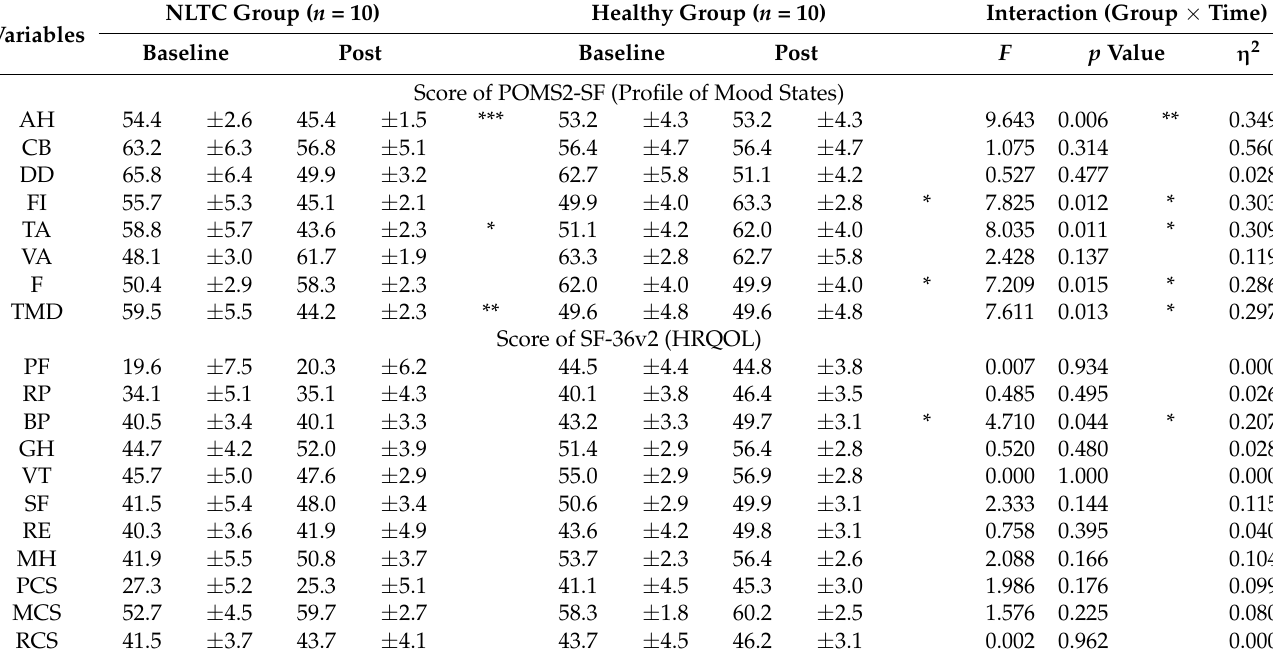
Table 2. Outcome of the exercise